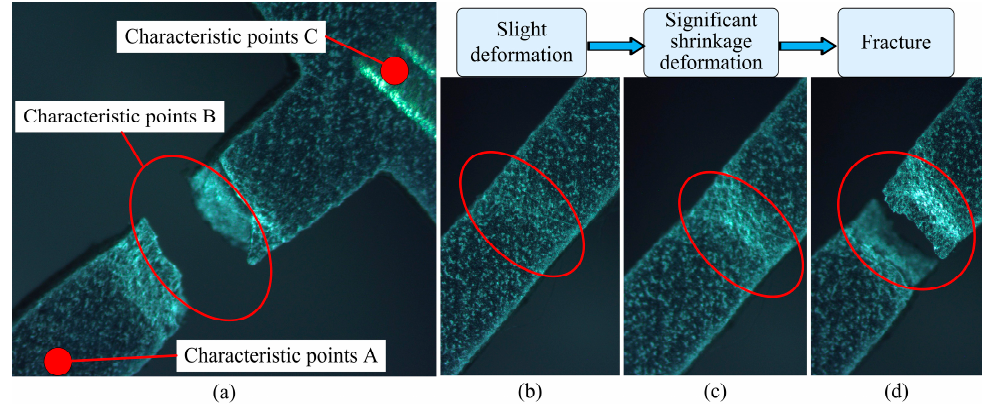
Figure 13. Fracture specimen image. ( a ) The state of the fracture specimen; ( b ) Slight deformation; ( c ) Significant shrinkage deformation; ( d ) Fracture.